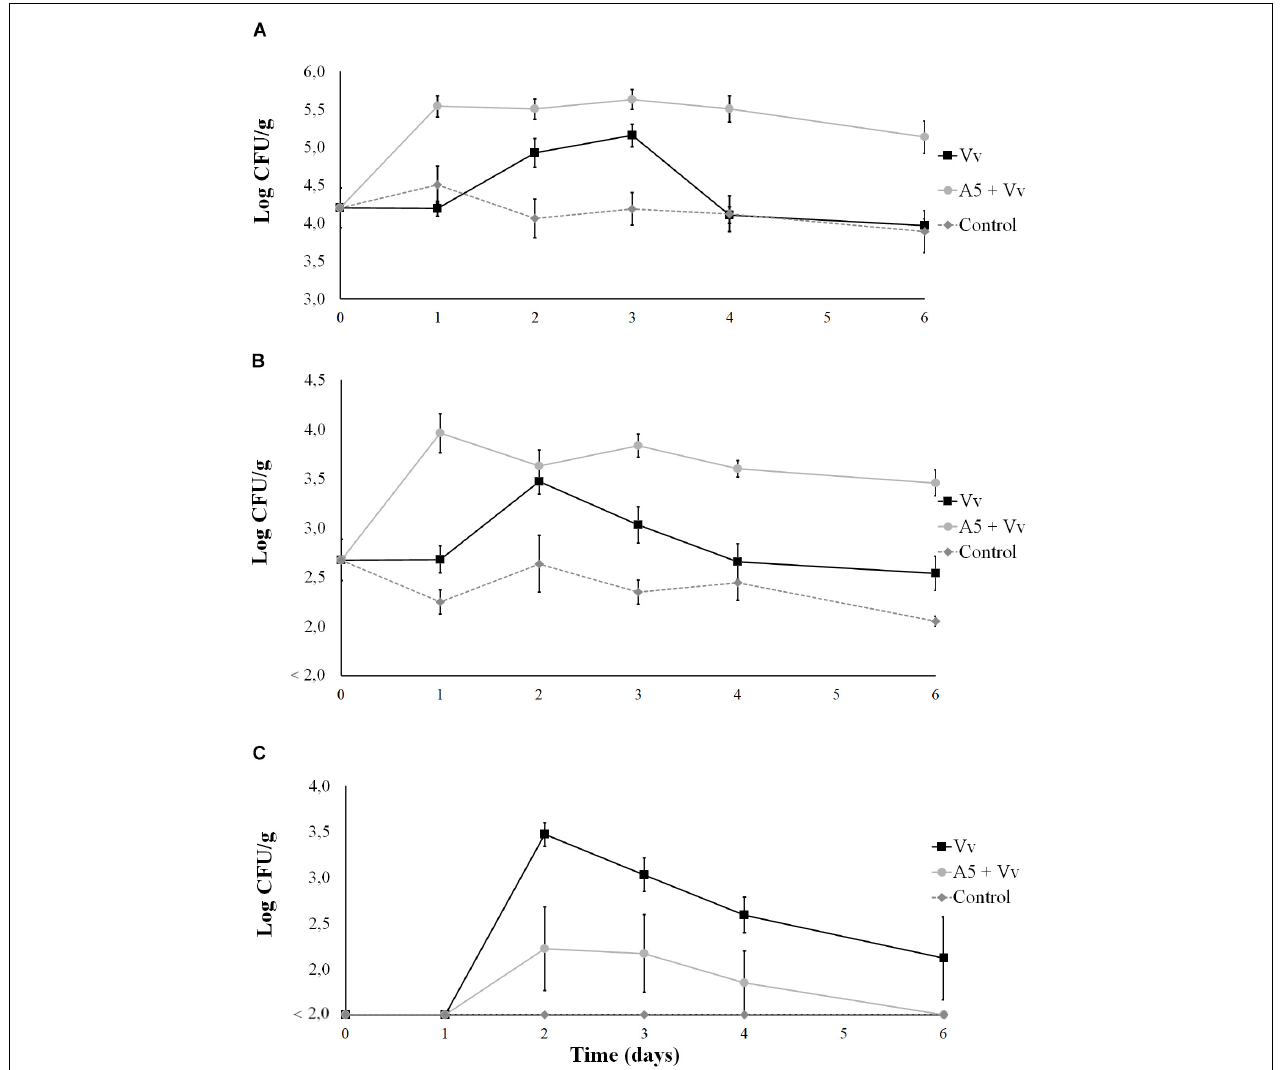
FIGURE 8 | Total aerobic bacteria (A) , total vibrio (B) , and Vibrio vulnificus (C) levels in oysters from bioassay 3 (inoculation with A5 prior to inoculation with V. vulnificus ). Three treatments are shown: Vv inoculated with V. vulnificus only ( (cid:4) ), A5 + Vv first inoculated with A5 and then with V. vulnificus ( • ), and control ( (cid:7) dotted line). The absence of colonies is represented as below the limit of detection (LOD) ( < 2.0 log